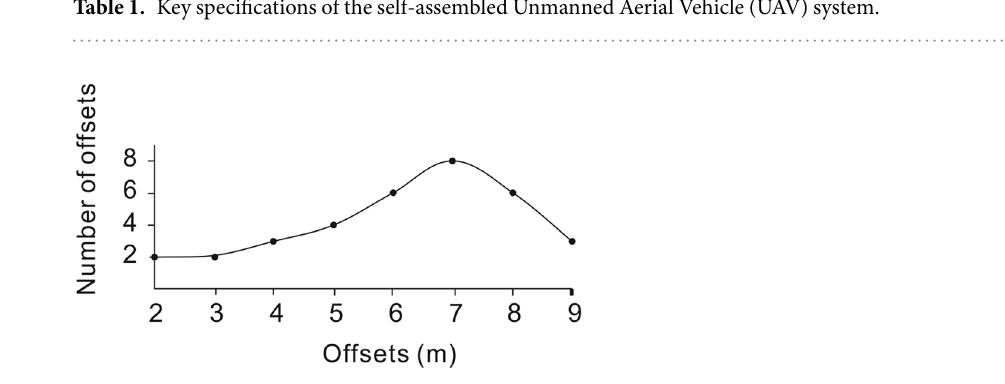
Reconstruction of the seismic offsets. A seismic offset is the displacement created by an earthquake 12, 17, 25, 26 . The main goal of the reconstruction of seismic offsets is to link the lateral displacements with individual pal- eoearthquakes. Researchers use imagery to observe and measure the earthquake produced surface offsets, which include the offset caused by the most recent earthquake (MRE) and the cumulative offsets 27, 28 . To document the distribution of offsets along the rupture trace of the fault, we reconstructed them based on high resolution orthoimages combined with the topographic profiles derived from the DEM to assist in the interpretation and measurement of the offset markers, which are mostly terrace risers and river channels. The offset of these features can only have accumulated since the abandonment of the terrace tread, assuming that the feature is contempora- neous with the terrace. The fault trace is mapped and the preferred offset values are determined by realigning each marker (terrace riser, gully, and abandoned channel) that has been displaced by fault motion based on both image interpretation and the topographic data (Fig. 6a,b and d). Targeting the clearest offset geomorphic features, we determined the seismic offsets (Fig. 7) by linearly projecting the correlative markers into the fault trace by eye and measuring the range of horizontal offsets 29 . First, we interpreted/identified the geomorphic markers that have been displaced by the motion of the fault. Then, we cut the image along the fault lines and realigned the offset markers. Finally, we measured the length of offset caused by motion on the fault. To evaluate the uncertainty of the recent small offset, we carefully checked the image for offsets from 2 m to 9 m (Fig. 8). To evaluate the uncertainty of the cumulative offset, we referred to the method of Gold et al . 29 . We considered two projections for each marker: one based on the trend of the terrace riser/center of the river channel nearest the fault line and a second based on the average trend for the entire length of the terrace riser/center of the river. The error bars for these measurements were determined based on the maximum value between the best fit measurements and the maximum/minimum measurements 26, 29 .